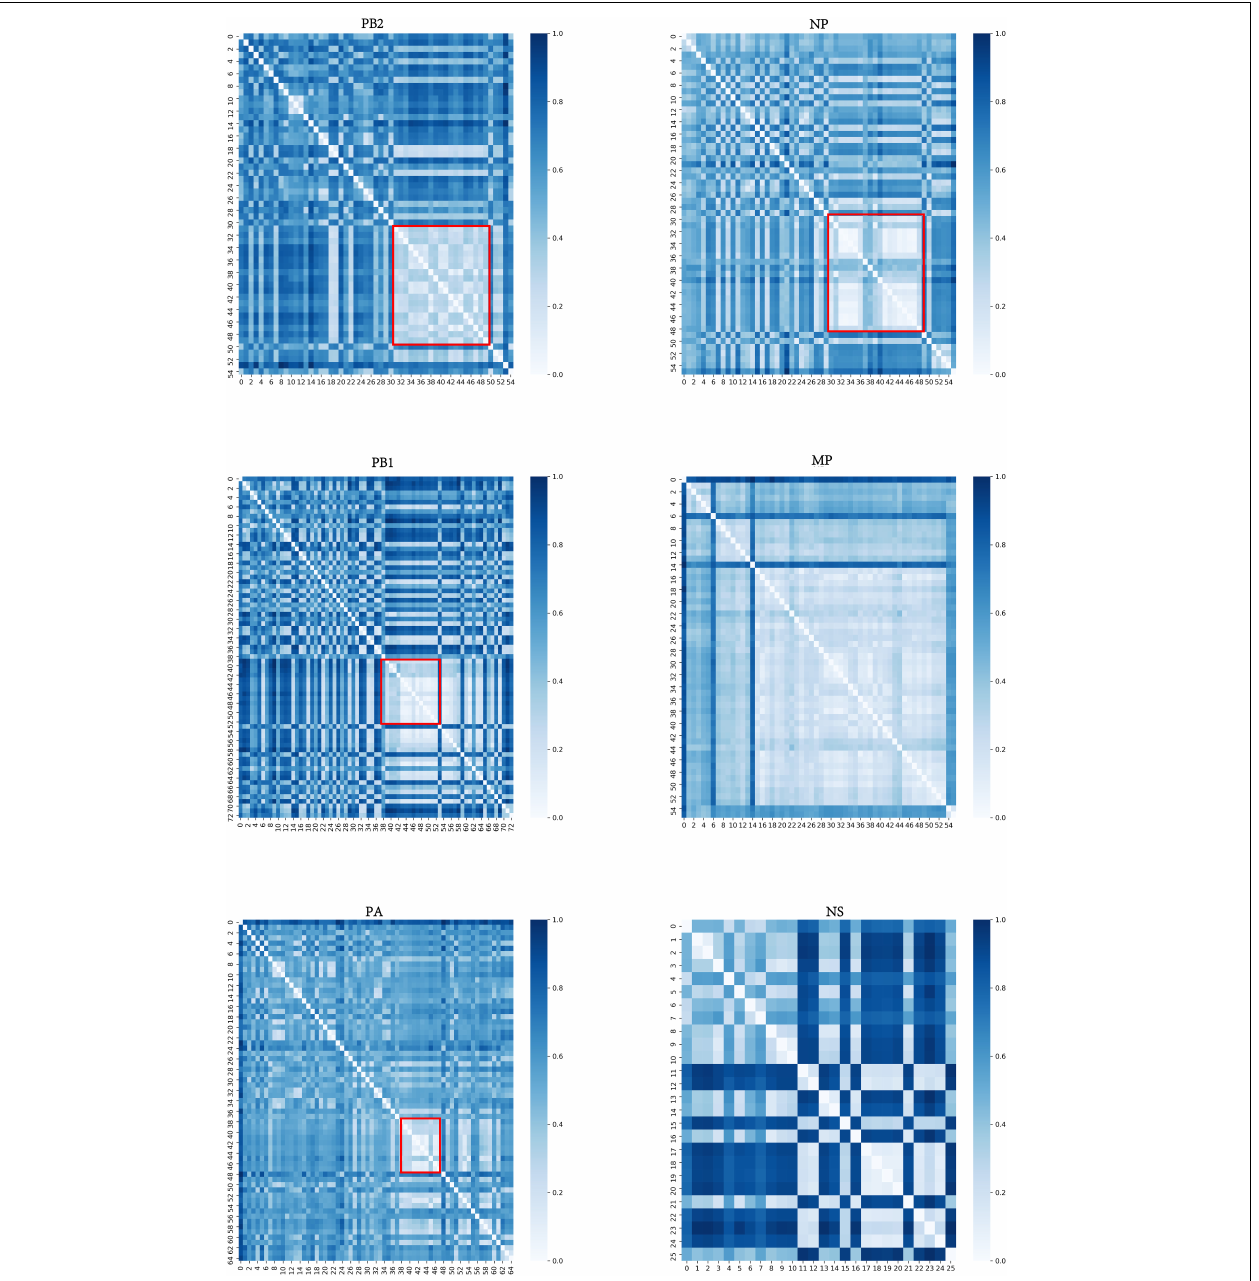
FIGURE 3 | Distance matrix of typical clusters of six internal segments. The horizontal and vertical coordinates represent typical clusters. The color shading corresponds to the distance between typical clusters. The darker the color is, the more distant the corresponding two typical clusters are. The light-colored areas (marked by a red box) indicate that those typical clusters have relatively close distances. The distance matrices of MP and NS segments are not marked as they have few